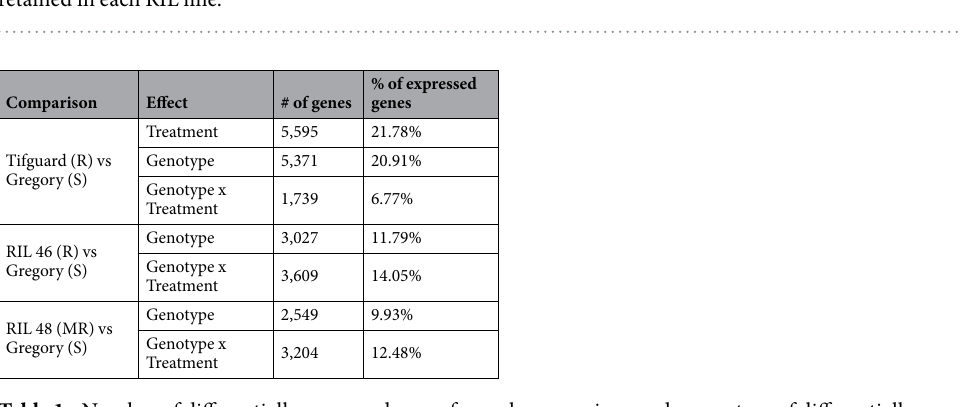
Figure 1. Physical map representation of A . cardenasii introgression in Tifguard, Line 46, and Line 48. Physical mapping is based on mapping of 555 SNPs diagnostic for A . cardenasii onto the A . duranensis reference pseudomolecule A09. Distinction between Gregory and Tifguard based on SWEEP filtered parental SNPs retained in each RIL line.